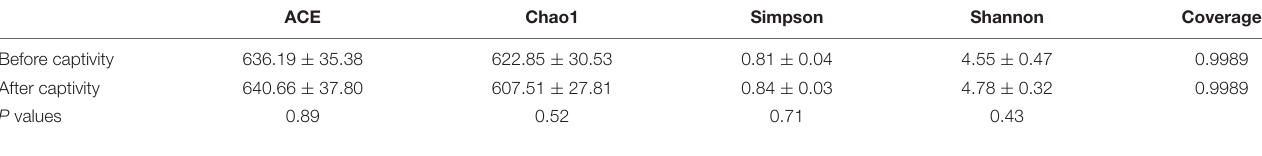
TABLE 1 | Comparisons of gut microbial abundance and diversity indices between the common kestrels before and after captivity.